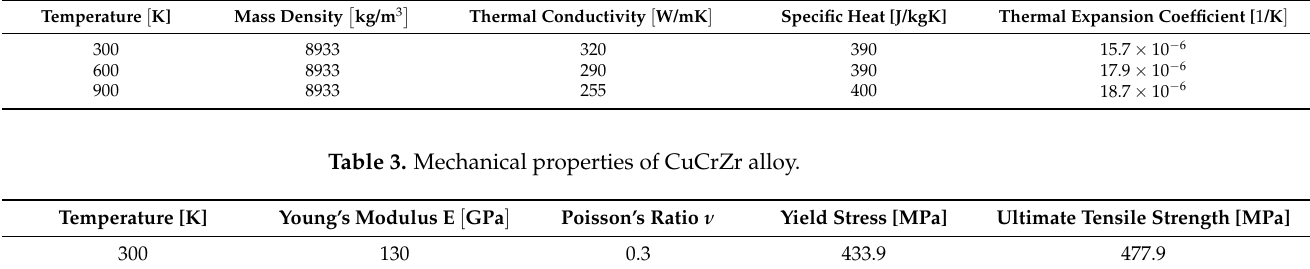
Figure 6. ( a ) Thermal and structural boundary conditions; ( b ) Convective boundary conditions. The combustion chamber was realized with three different materials, as shown in Figure 5: